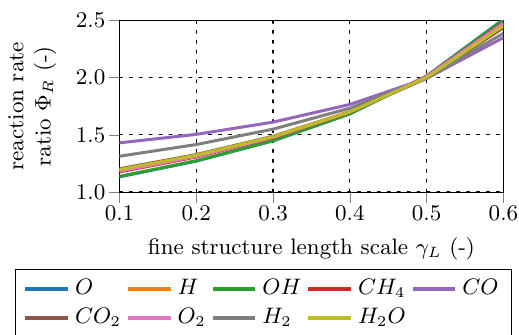
Figure 7. Comparison of the normalized PSR and PFR mean reaction rates for selected radical species test cases. ( Top ): Temperature 2200 K, fine structure residence time 1 s, ( Bottom ): Temperature 2000 K, fine structure residence time 10 − 7 s.